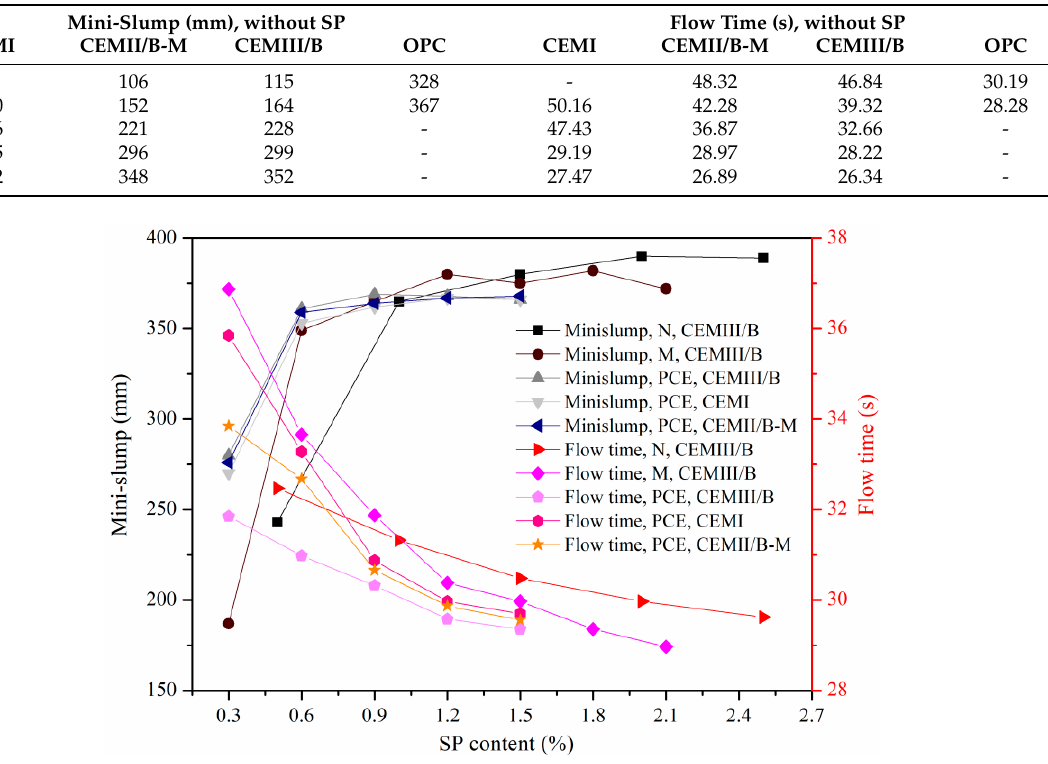
Figure 4. Effect of SP and cement type on mini-slumps and flow times of SMCG at the W/S of